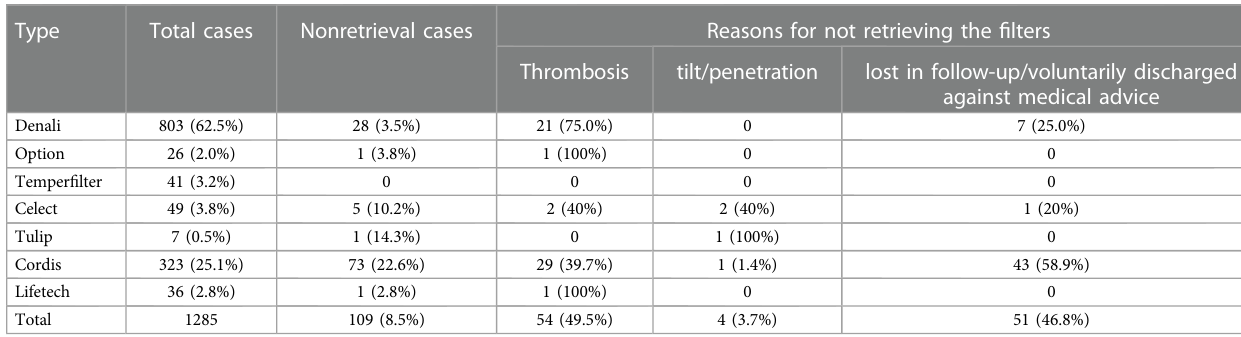
TABLE 2 Information of retrieval vena cava fi